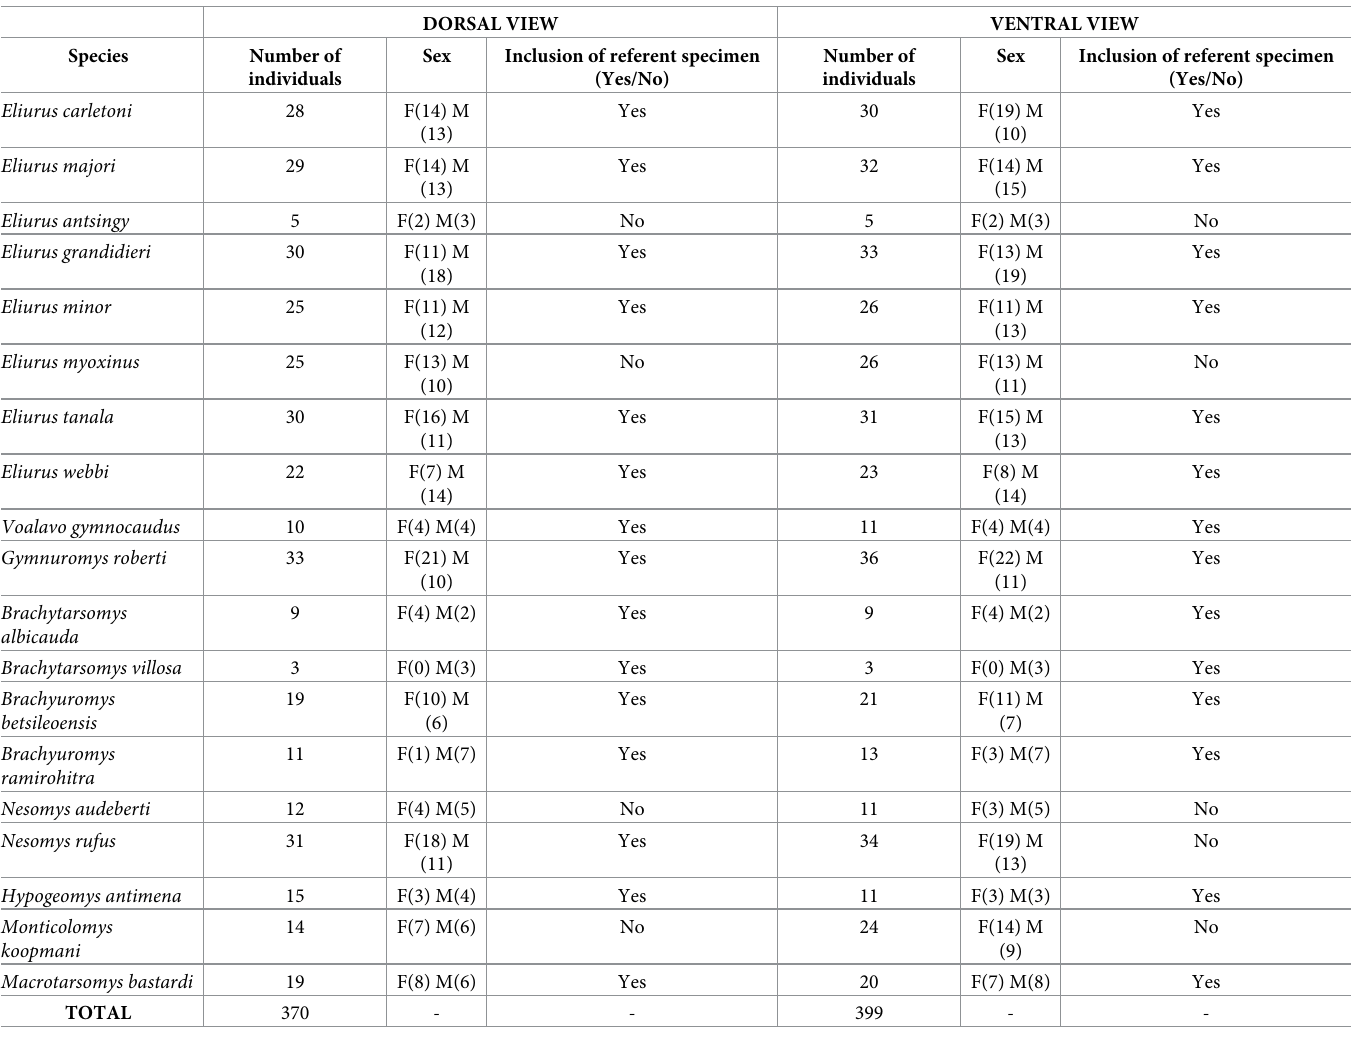
Table 1. Summary of the photographic sampling.